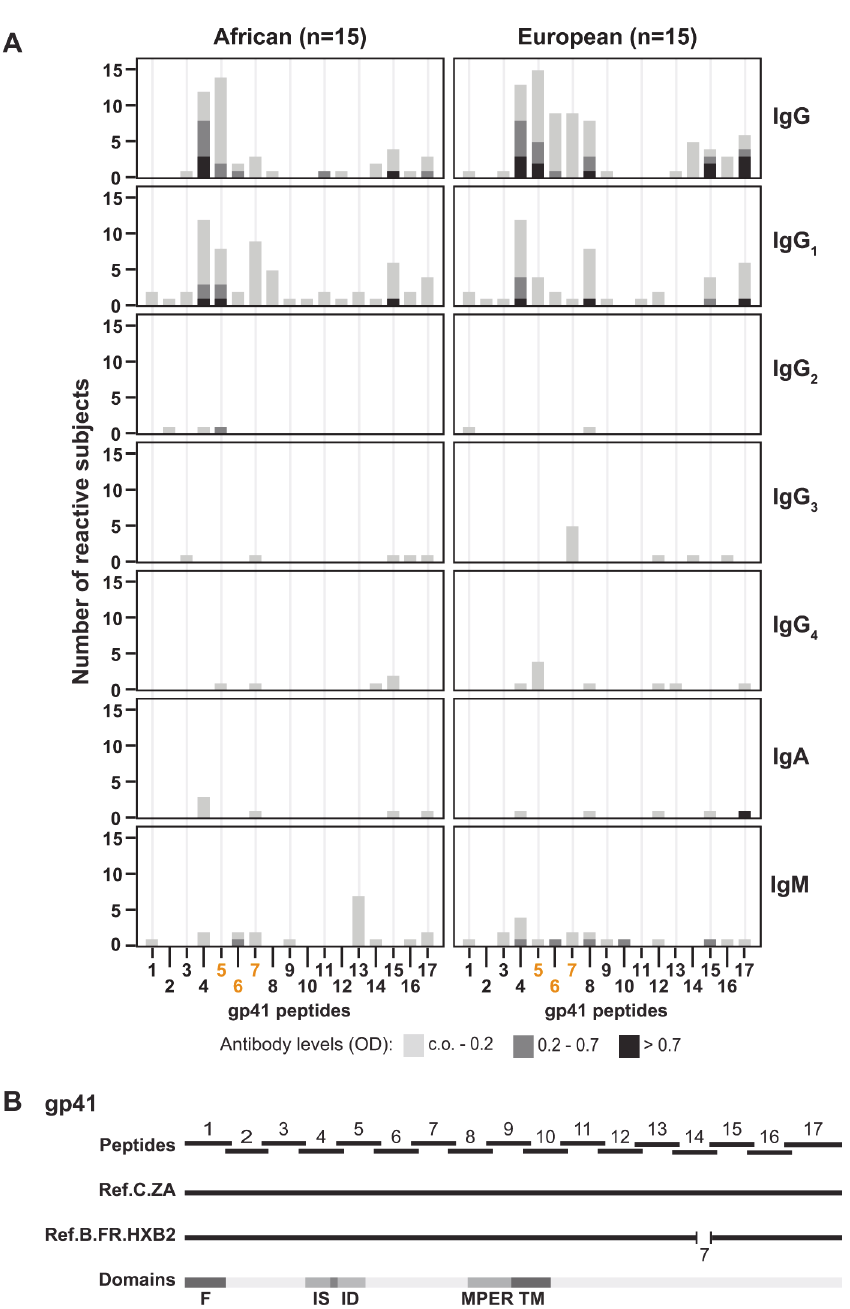
Fig 2. Antibody responses to gp160 and HIV-1 clade C gp41-derived peptides. (A) Frequencies and intensities (y-axes: number of reactive sera; OD levels color-coded) of IgG, IgG subclass, IgA and IgM responses of African (left) and European (right) patients to 17 overlapping gp41 peptides (x-axes: peptides 1 – 17, peptides with predicted N-linked glycosylation sites: orange). (B) Position of overlapping gp41 peptides in gp41 of the HIV-1 clade C South African strain (Ref.C.ZA) and of the reference strain HXB2 (Ref.B.FR. HXB2). A gap (number of missing amino acids is displayed) in gp41 from clade B, required for optimal sequence alignment, is indicated. Relevant protein domains/epitopes described for gp41 clade B are indicated (F, fusion peptide; ID, immunodominant region; IS, immunosuppressive region; MPER, membrane proximal external region; TM, transmembrane domain).